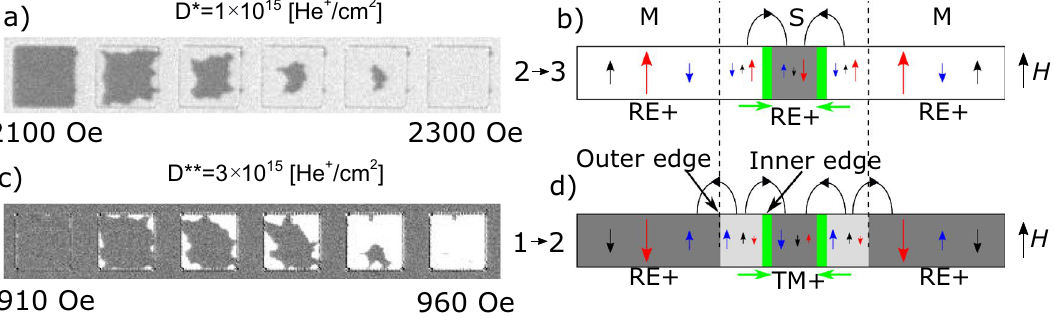
Figure 5. ( a , c ) Close-up image of one representative square with a = 25 µm illustrating the magnetization reversal for 2 → 3 and 1 → 2 transitions after IB with dose D * and D **, respectively. ( b , d ) Sketch of the effective magnetization, and the magnetization of the Co and Tb subsystems (with the color convention of Fig. 3) in cross sectional view. The stray fields from magnetic domain structure are schematically presented in ( b ) and ( d ). Green arrows show the direction of DWs